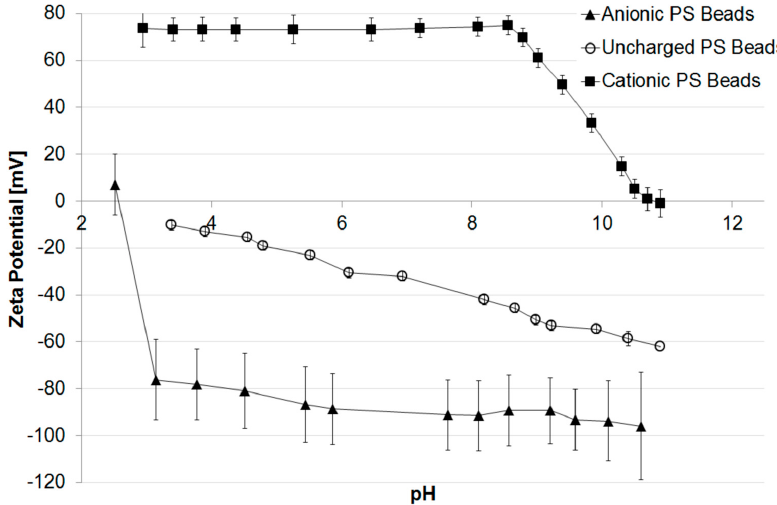
Figure 1. Zeta potential of differently charged PS beads vs. pH.